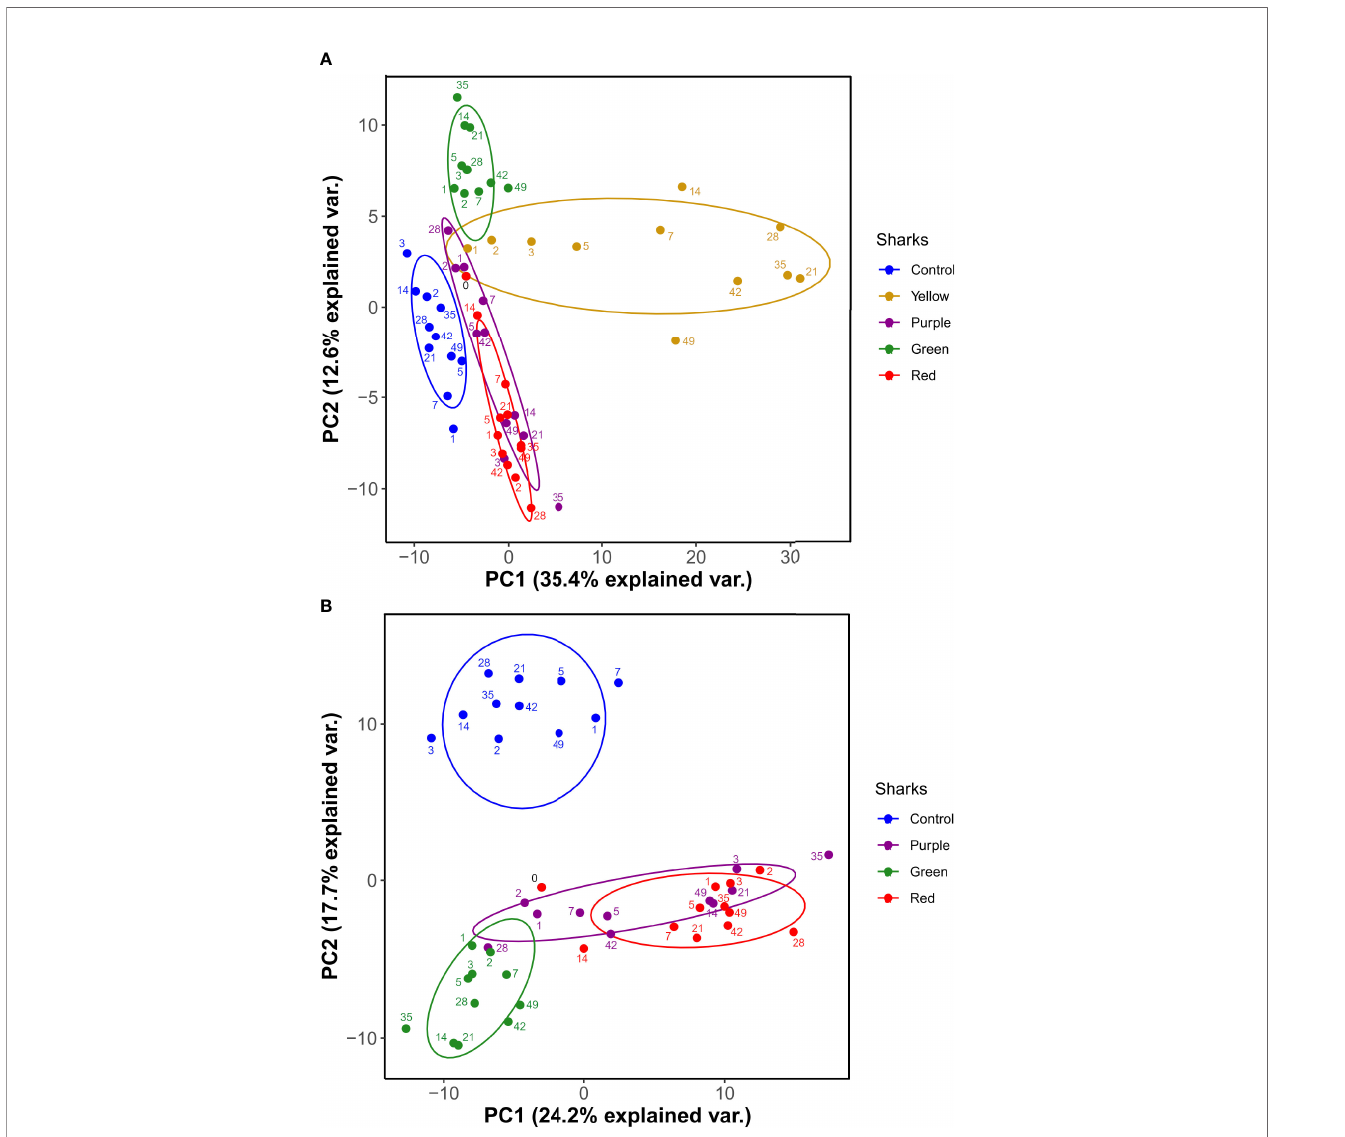
FIGURE 3 | PCA of nurse shark plasma proteome (260 protein dataset) (A) for all sharks and (B) following the exclusion of shark ‘ Yellow ’ . Ellipses are 95% con fi dence intervals around the